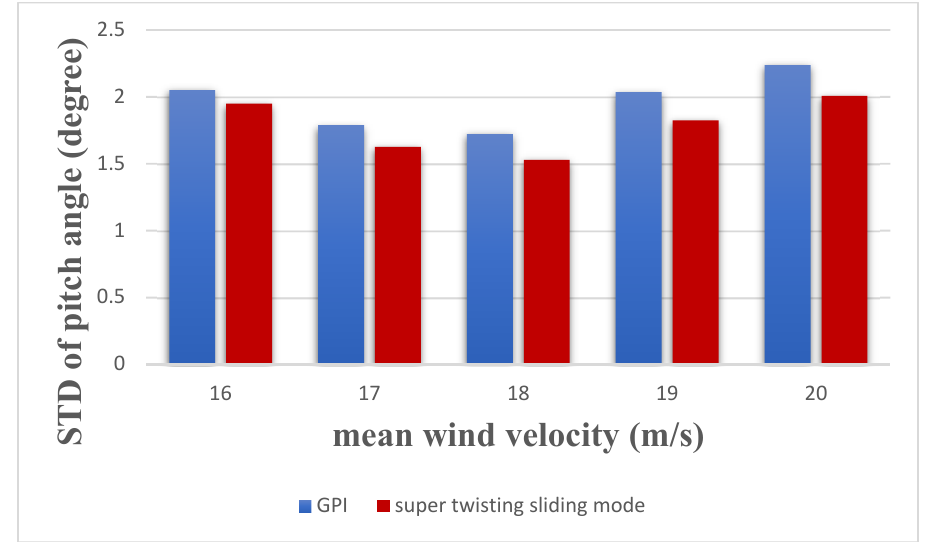
Figure 18. Comparison between the STD of pitch angle signal in gain schedule control approach and super twisting sliding mode control in different mean wind speed values with turbulence intensity 10%.